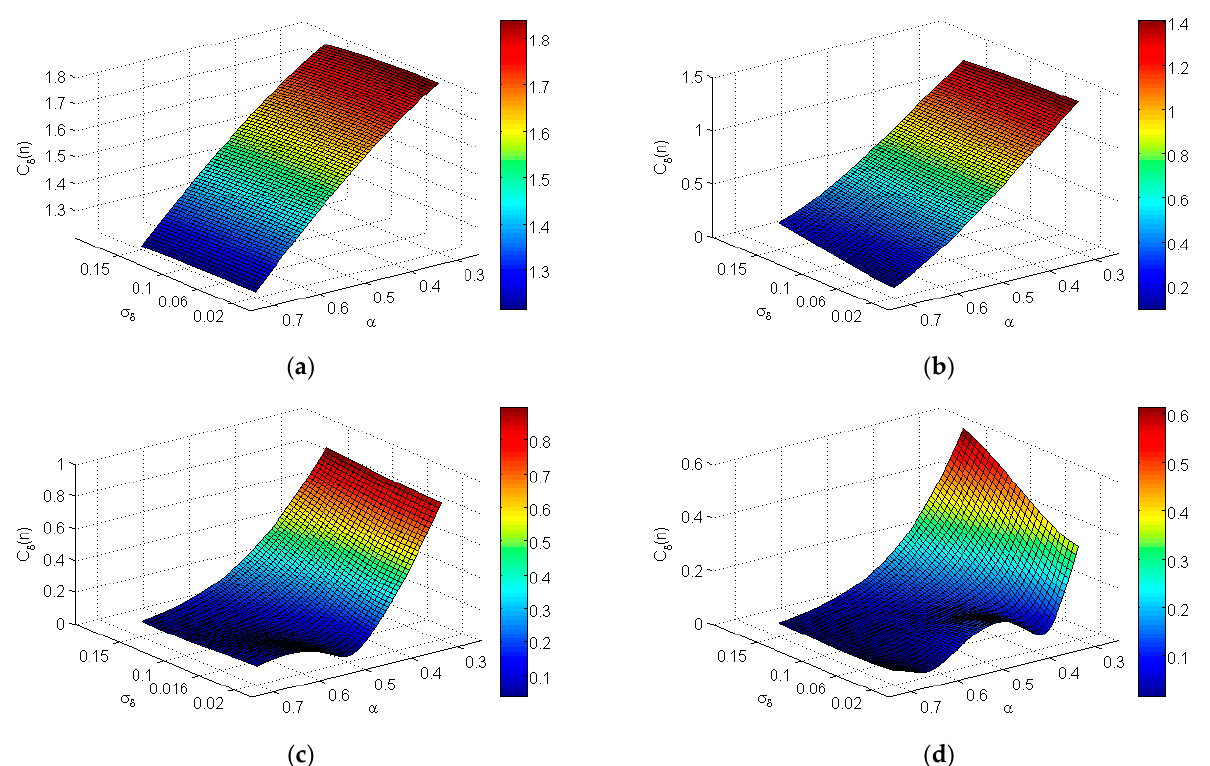
Figure 2. Crowd reduction factor C ψ ( n ) . ( a ) n = 1. ( b ) n = 2. ( c ) n = 3. ( d ) n =